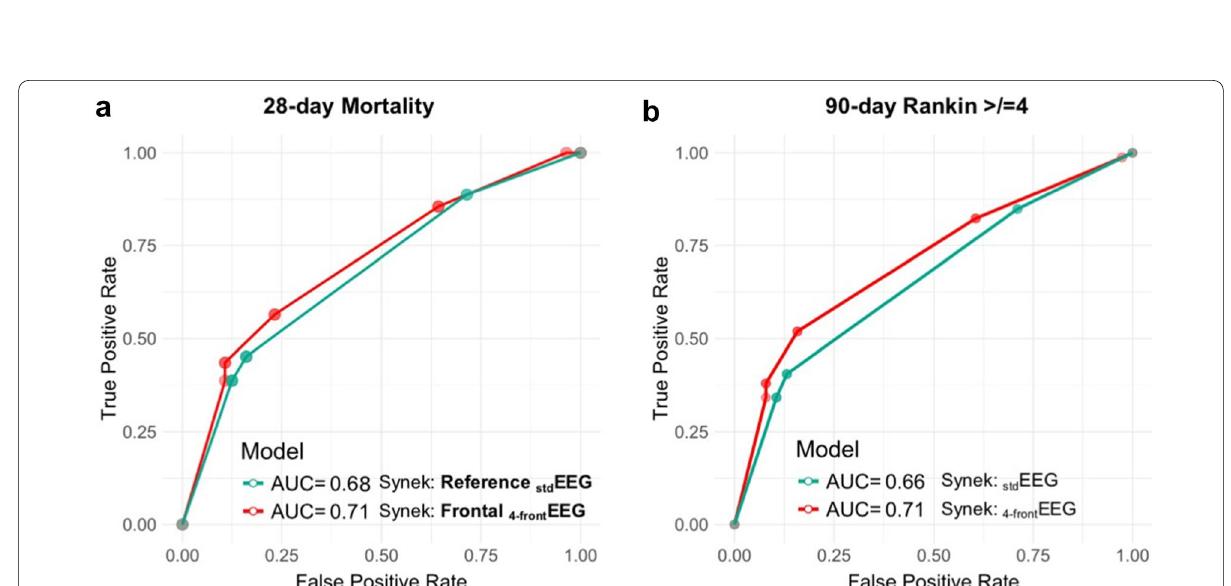
Fig. 3 Performance of standard ( std EEG) and frontal ( 4‑front EEG) montages for prediction of 28‑day mortality and 90‑day poor functional outcome. The Synek score, determined by a trained intensivist on 4 frontal electrodes, was associated with 28‑day mortality (AUC and sensitivity 0.57) and 90‑day poor functional outcome (Rankin score comparable to an expert’s interpretation on 21 electrodes (AUC sensitivity 0.30,